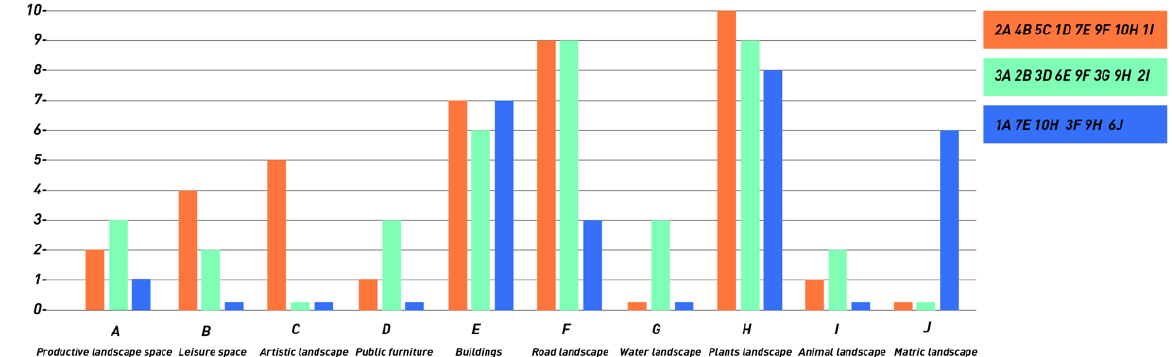
Figure 8. The types of landscape are spread over three different areas.